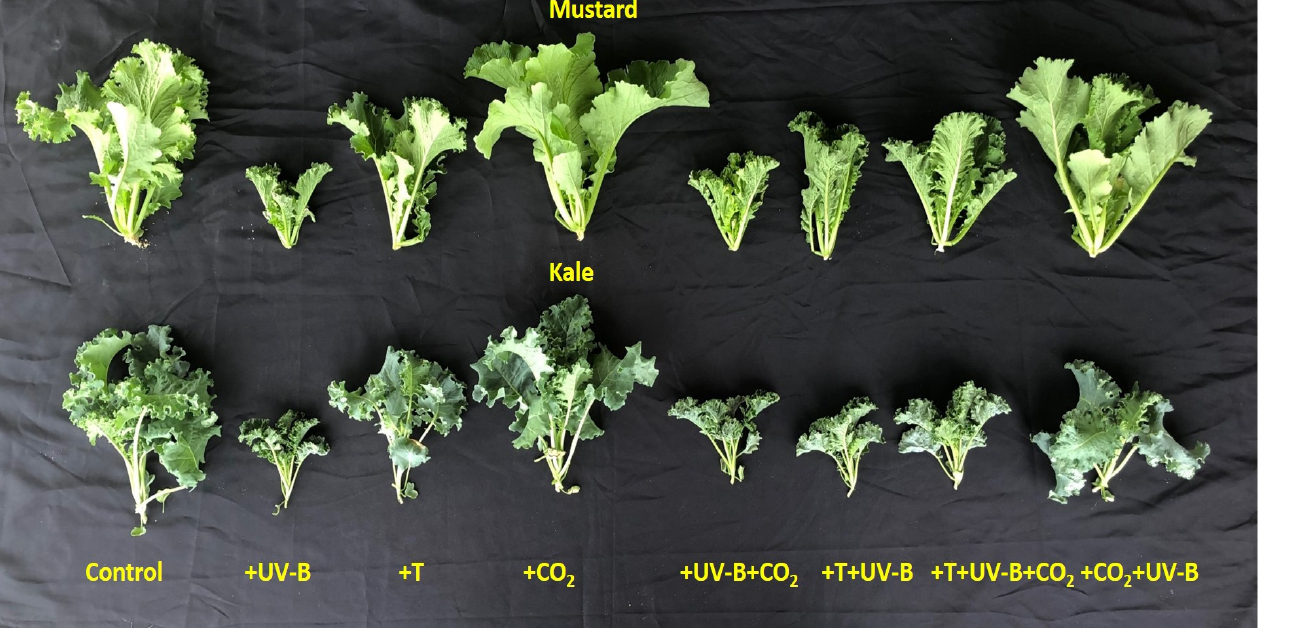
Figure 1. A pictorial presentation of the impact of CO 2 concentration (control, 400 μ mol mol − 1 and +CO 2 , 720 μ mol mol − 1 ), elevated temperatures (25/17 °C and 35/27 °C (day/night)), and radiation (control, 0 and +UV-B, 10 kJ m − 2 d − 1 ), and their interactions on the morphological growth of kale and mustard.